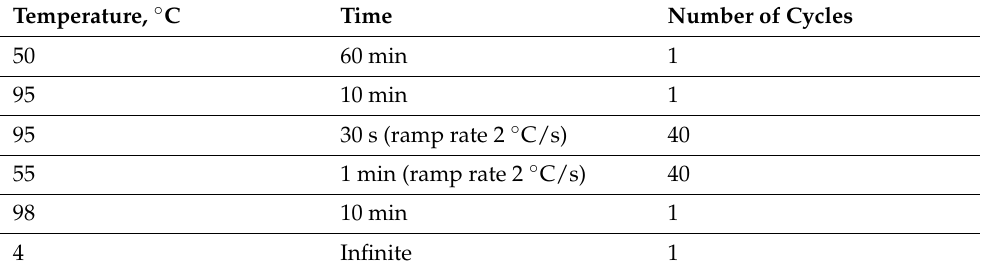
Table 3. Thermal Cycler